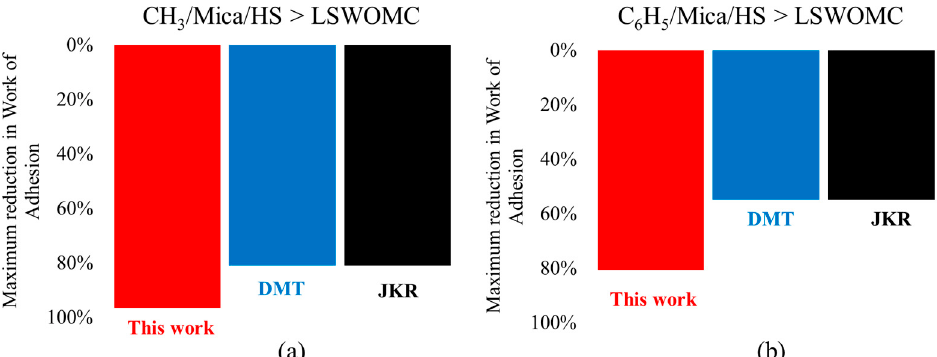
Figure 13. The maximum reduction in the work of adhesion from high salinity (HS) to low salinity conditions with ionic tuning (LSWOMC). ( a ) Maximum decrease obtained in this study for a CH 3 tip on mica was 97%, compared to 81% based on JKR [57] and DMT [58] models. ( b ) Maximum decrease obtained in this study for a C 6 H 5 tip on mica was 81%, compared to 55% based on JKR [57] and DMT [58] models.